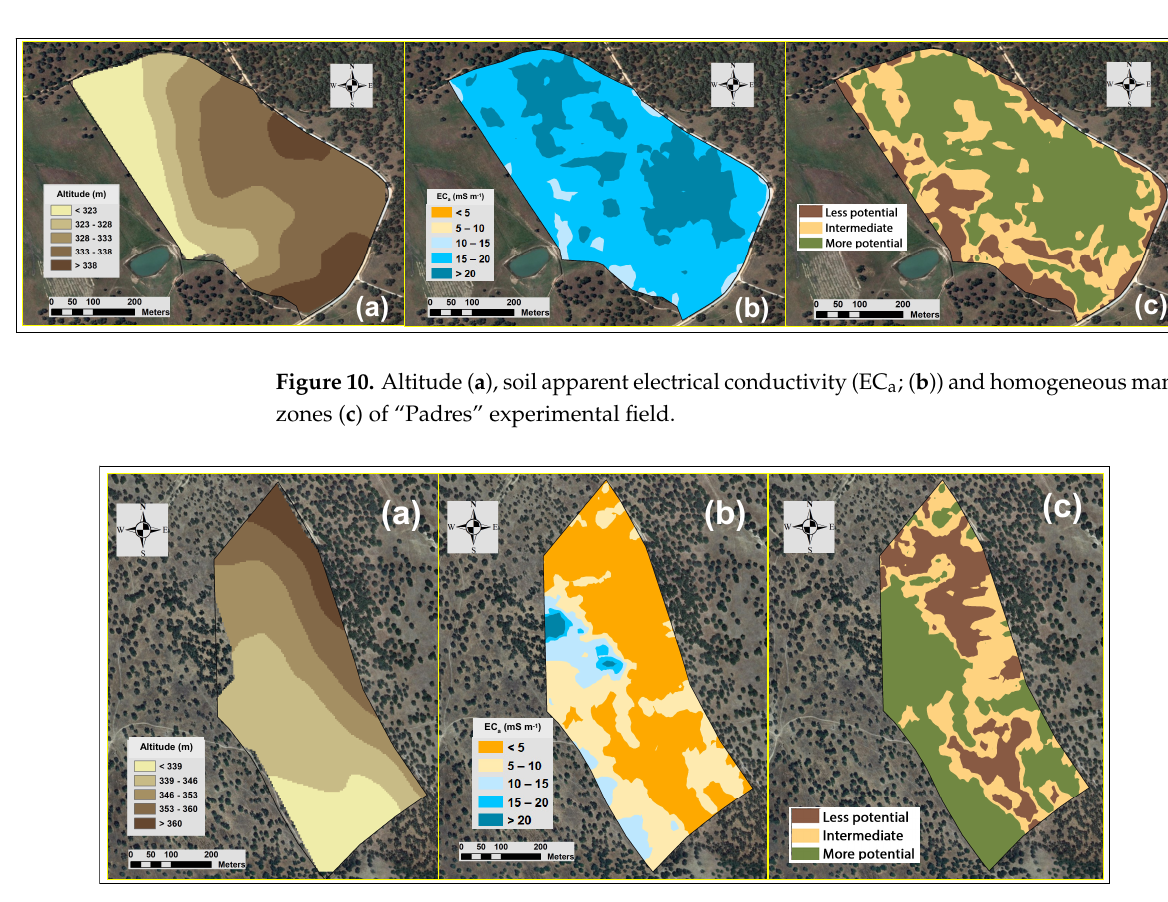
Figure 11. Altitude ( a ), soil apparent electrical conductivity (EC a ; ( b )) and homogeneous manage ‐ ment zones ( c ) of “Tapada” experimental field. Table 6. Mean values of the soil parameters in each management zone (less, intermediate and more potential) within each experimental